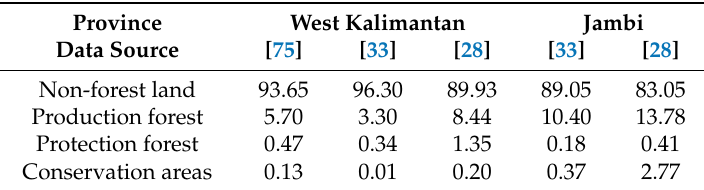
Table 4. Likely source area of palm oil produced in West Kalimantan and Jambi according to three spatial data sources, expressed as %, assuming homogenous productivity per unit land.